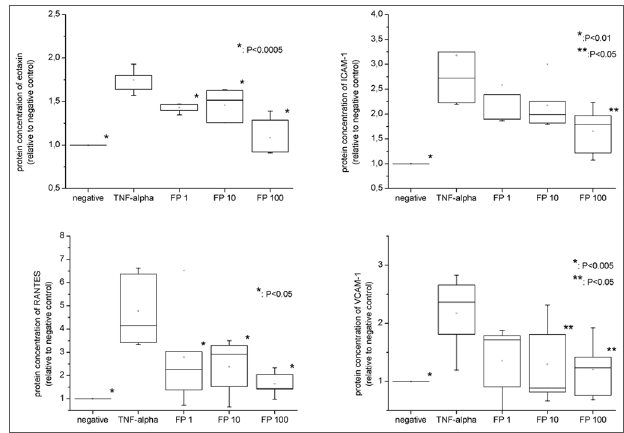
Figure 2. Protein levels of eotaxin, RANTES, VCAM-1 and ICAM-1 measured by ELISA. All the relative values were compared to negative control (considered as 1.0).